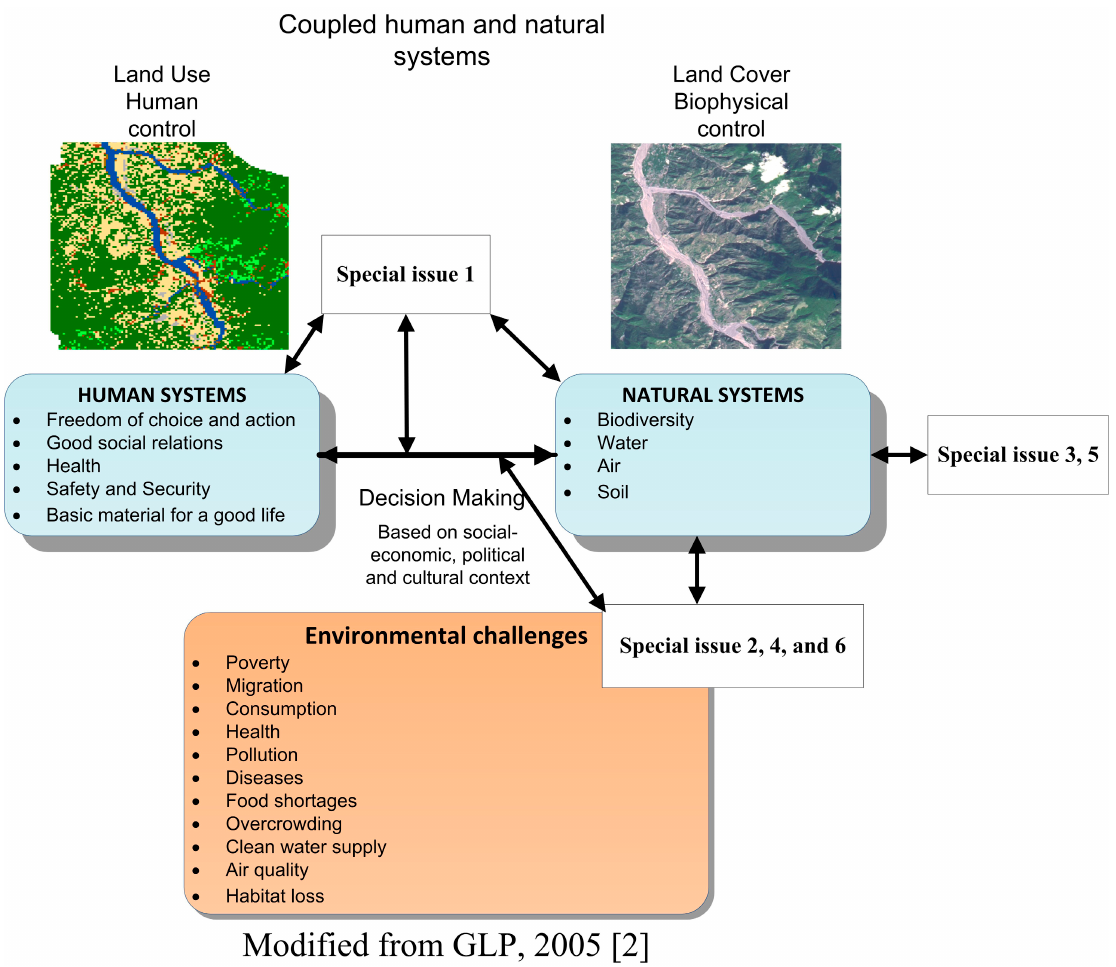
Figure 2. Conceptual framework of six special issues and associated environments.